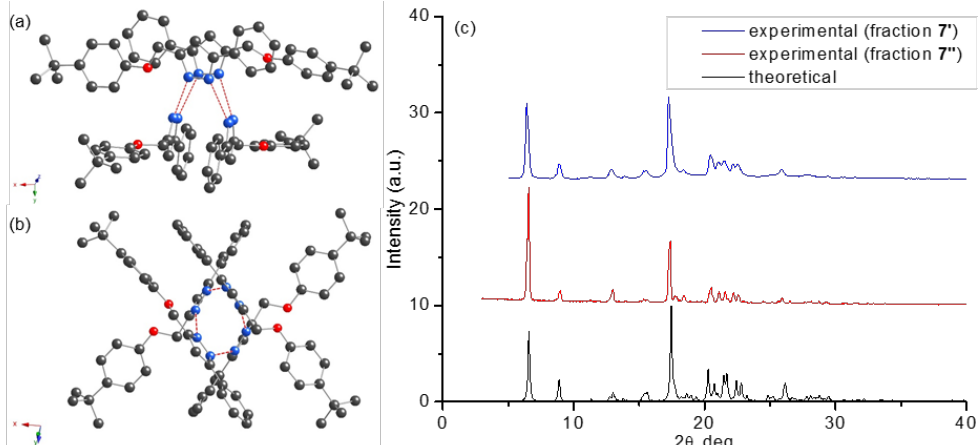
Figure 4. Side view ( a ) and top view ( b ) of hydrogen-bonded tetramer associates of compound 7 in crystal. Red dashed lines show H-bonds between N atoms of neighboring pyrazolyl units. C atoms are represented by gray spheres; N atoms are presented in blue; and O atoms are displayed in red. Disordered atoms of C, O, and H are not given. ( c ) Powder X-ray diffractograms of compound 7 (experimental and theoretical).